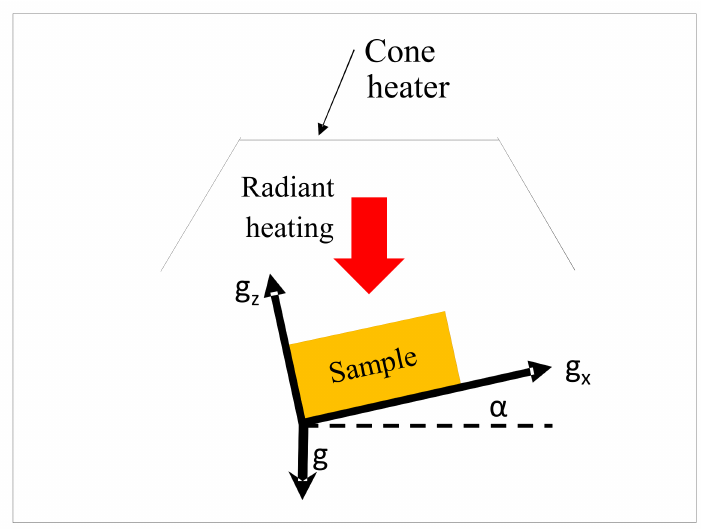
Figure 2. Schematic 2D diagram of the computational domain setup (not to